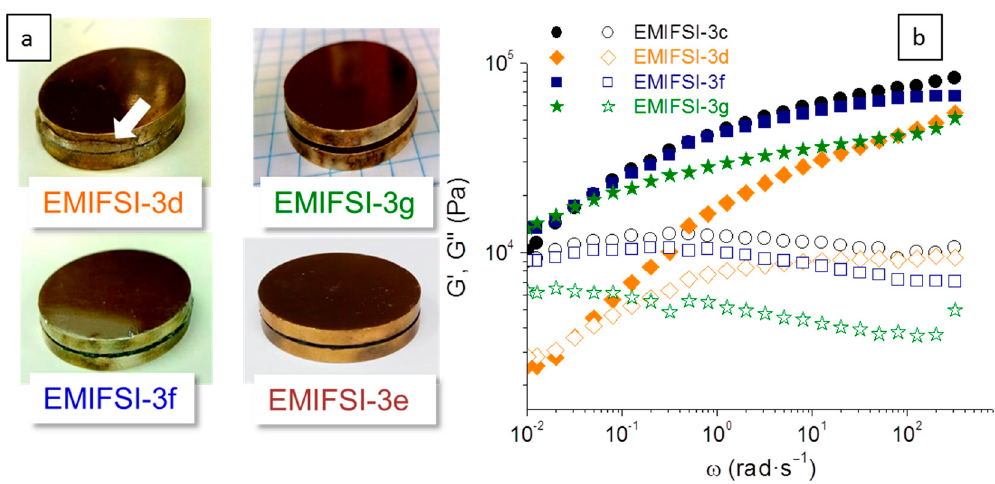
Figure 3. Rheology of the polymer electrolytes: ( a ) Pictures of the sandwiched electrolytes EMIFSI-3d, f, and g after enduring the creep text consisting of 0.5 kg for 20 min at 75 °C and then 20 min at 90 °C (see text for details). Picture of sandwiched EMIFSI-3e electrolyte after 10 months with 0.1 kg on top, and ( b ) shear storage G’ (solid) and loss G’’ (open) moduli at 75 °C for EMIFSI-3c, d, f, and g.